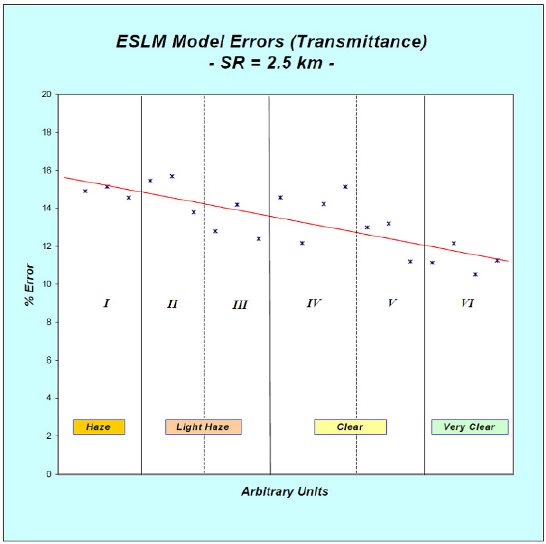
Figure 9. ESLM model errors (transmittance) for SR = 2.5 km.